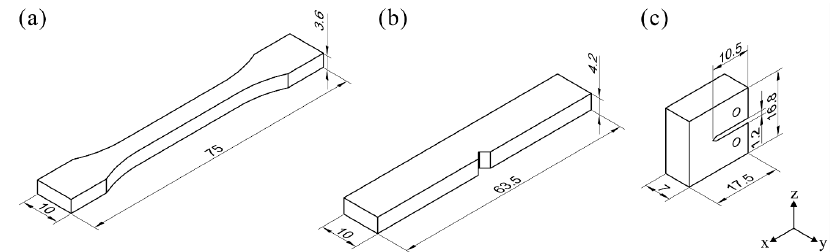
Figure 2. Dimensions for the 3D-printed PPS samples: ( a ) Tensile sample geometry; ( b ) Izod notched notched impact sample geometry; ( c ) compact tensile sample geometry.